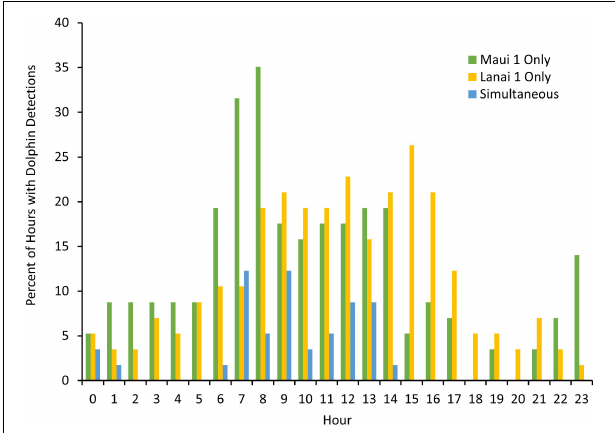
FIGURE 6 | Percent of hours in which Hawaiian spinner dolphin acoustic detections occurred in Maui 1 only, Lanai 1 only, or both bays simultaneously by hour of day from 05 October 2016 to 30 November 2016, a 57-day deployment (where 0 represents midnight, and 23 represents 2300